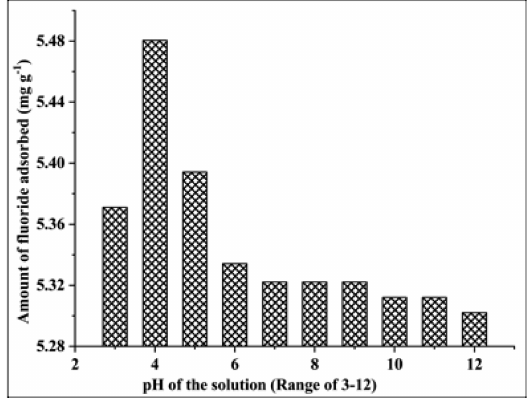
Figure 6. Amount and percentage of fluoride adsorbed over time in the absence of calcium (initial fluoride concentration: 15 mg L − 1 ) .